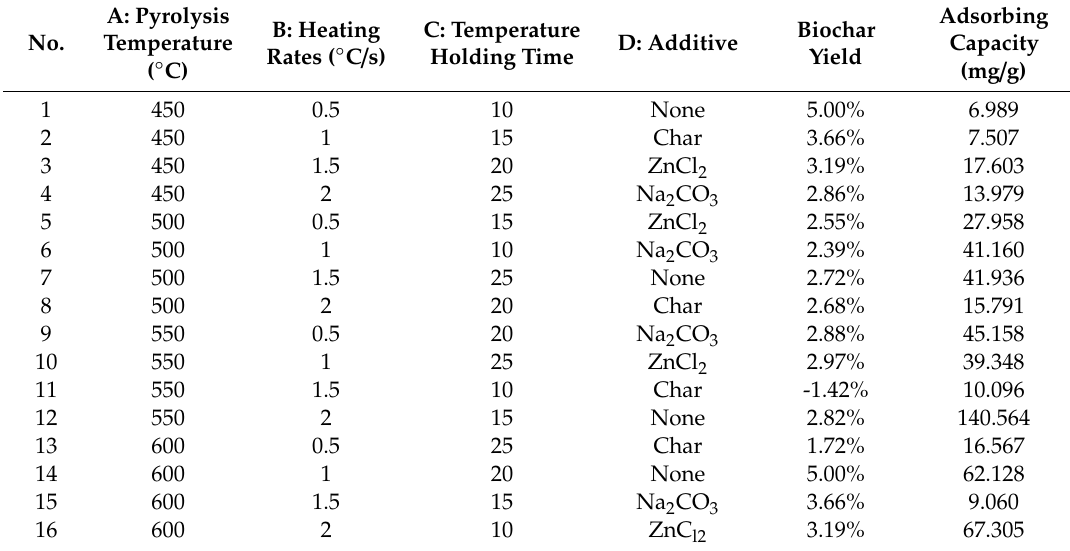
Table 3. The orthogonal experiment schedule and